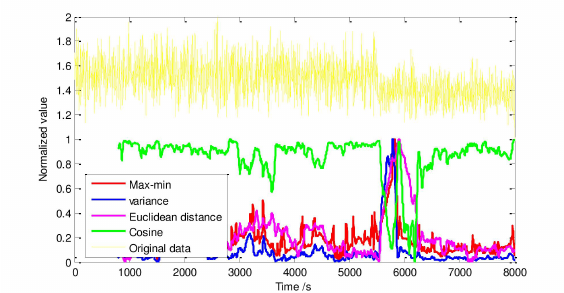
Figure 13. Detection example of weak PUE attack.